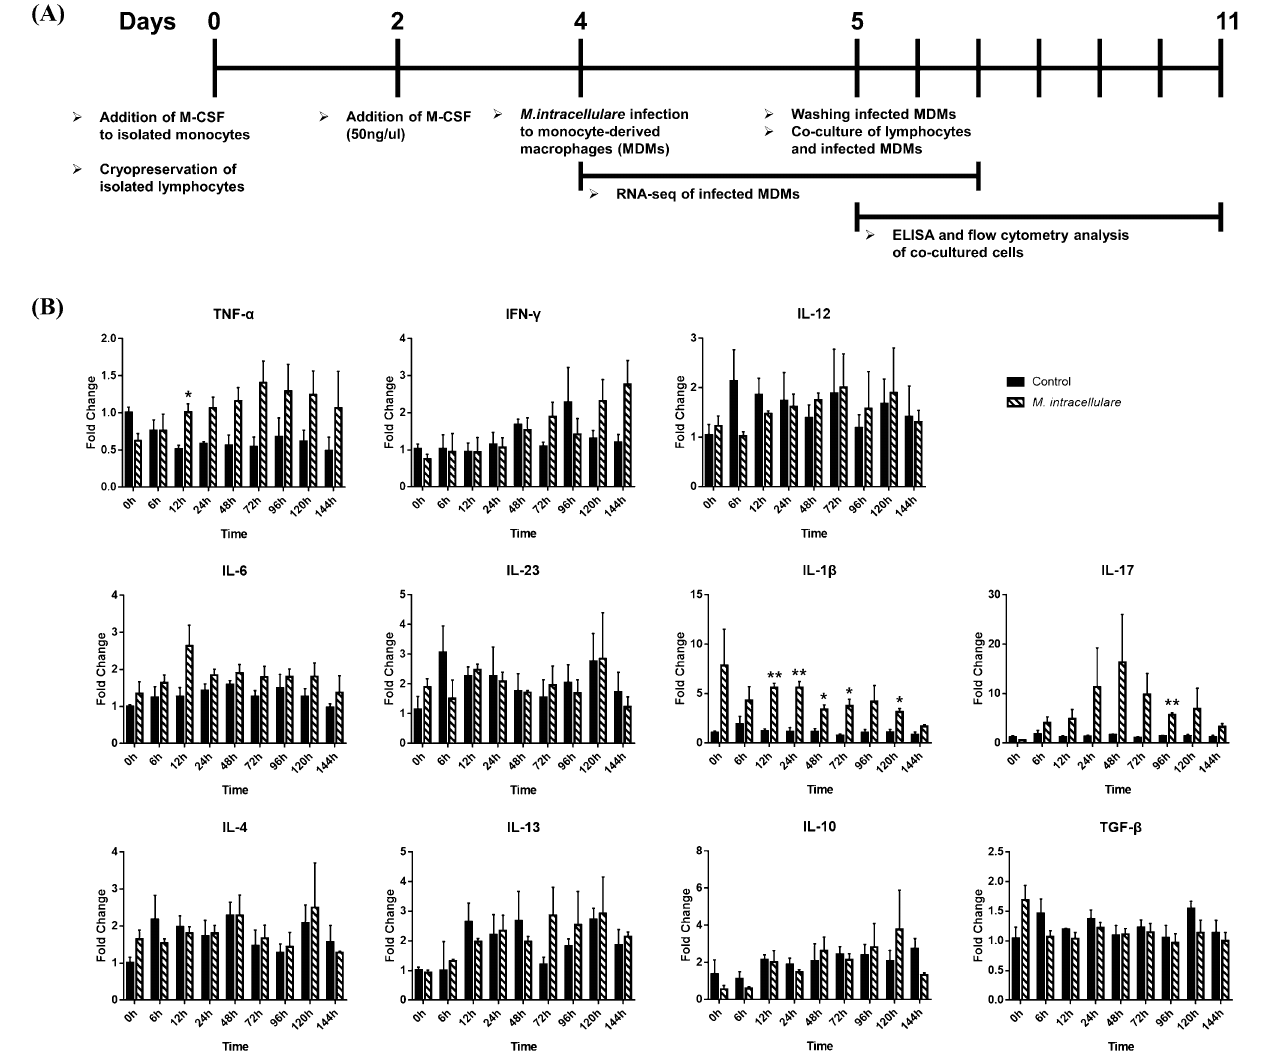
Figure 4. Differential cytokine expression in mRNA level of monocyte-depleted PBMCs co-cultured with M. intracellulare -infected canine MDMs. ( A ) Flowchart of co-culture experiment for the T helper cell response. ( B ) The cytokines TNF-α, IFN-γ, and IL-12 (Th1); IL-4 and IL-13 (Th2); IL-6, IL-23, IL-1β, and IL-17 (Th17); and IL-10 and TGF-β (Treg) were quantified based on their fold changes of the mRNA expression in canine monocyte-depleted PBMCs co-cultured with M. intracellulare -infected MDMs. The mRNA expression in non- infected cells at 0 h was given a value of 1 as a reference for fold change in expression. Each bar represents the mean ± SEM from three independent experiments in individual dogs. * p < 0.05, ** p <